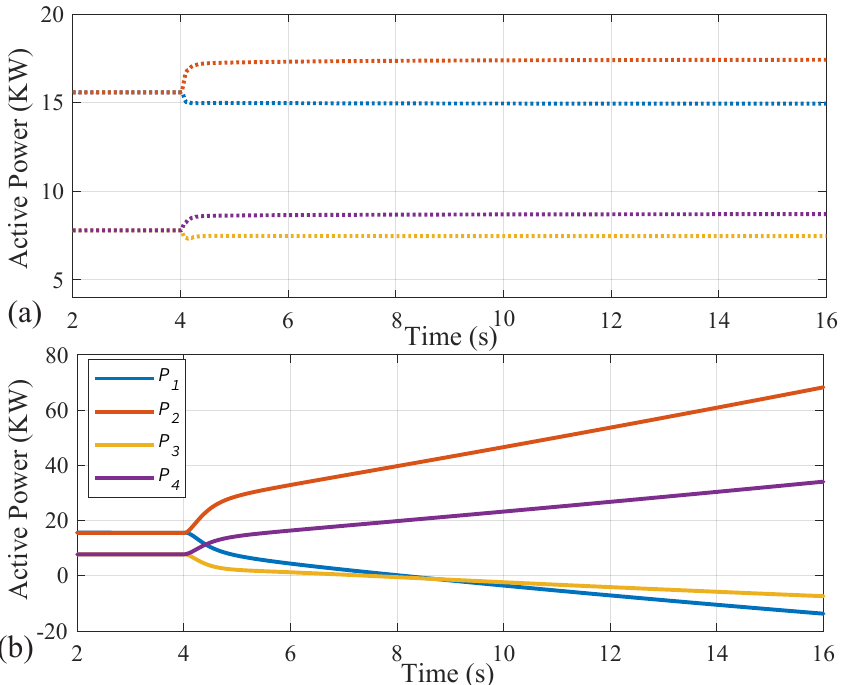
Figure 5. Active powers of inverters subjected to unbounded actuator attacks: ( a ) proposed resilient method and ( b ) conventional method.